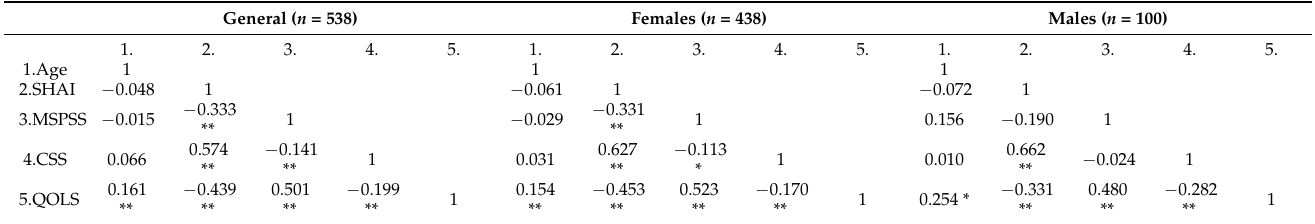
Table 2. Bivariate correlations.